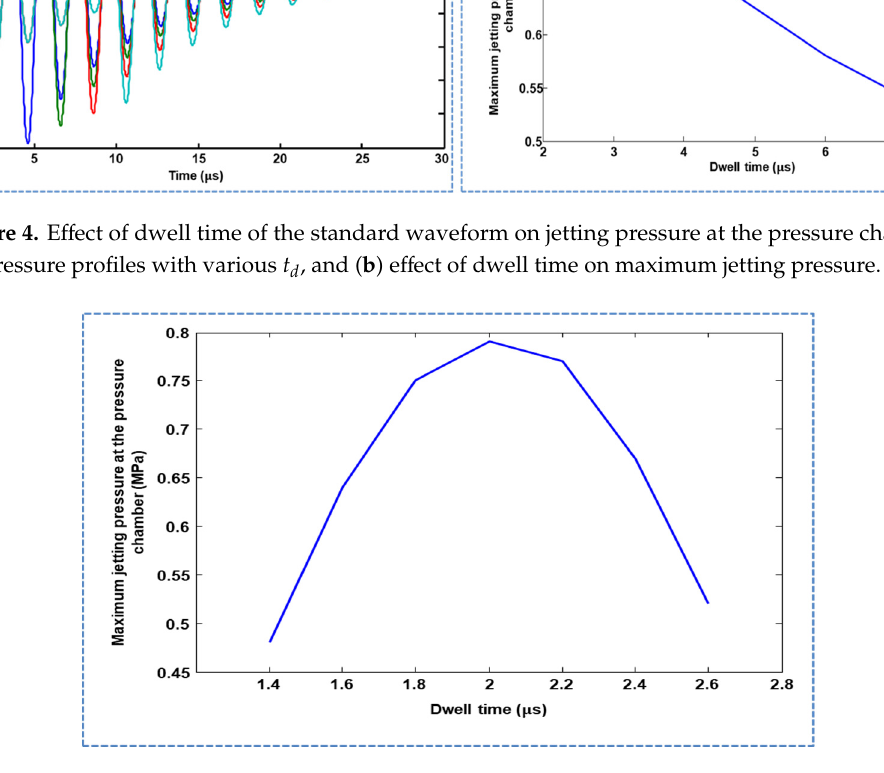
Figure 5. Effect of dwell time on jetting pressure at the pressure chamber with short time intervals.